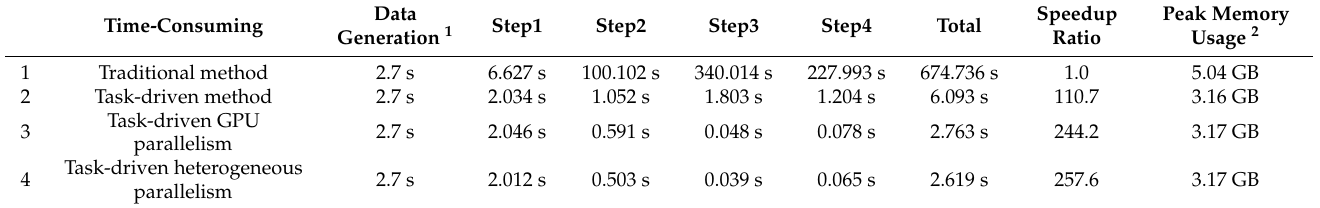
Table 1. Comparison of timeliness between the traditional method and the task-driven